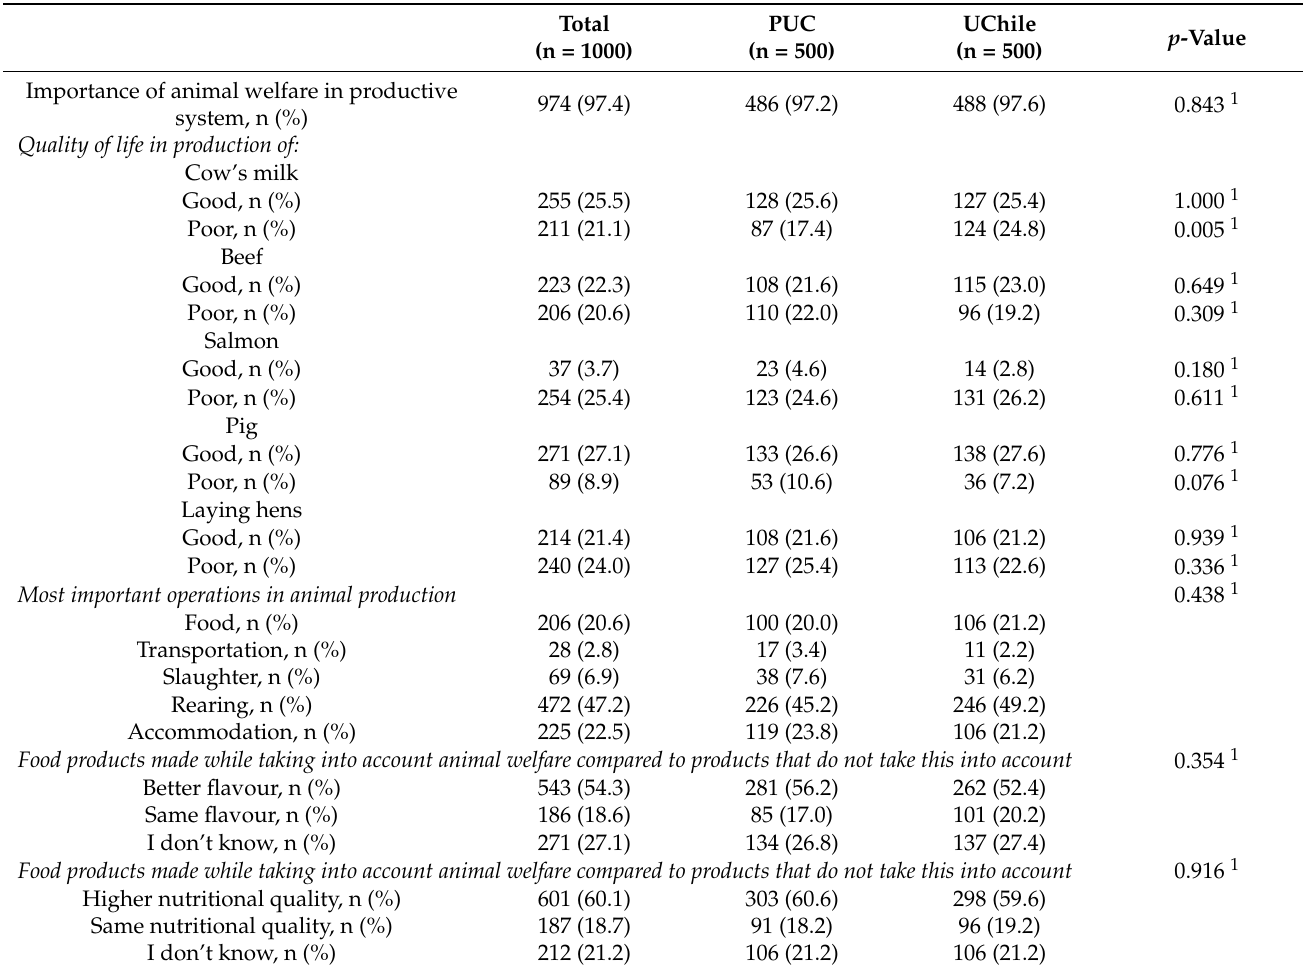
Table 4. Perceptions toward animal welfare of student from Pontificia Universidad Cat ó lica de Chile (PUC) and Universidad de Chile